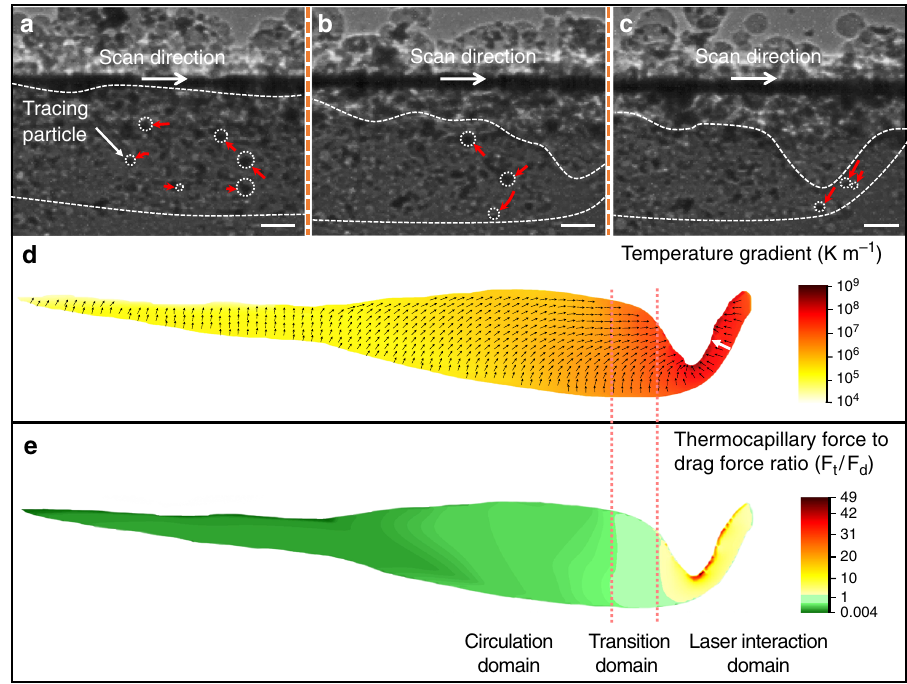
Fig. 3 Driving forces for pore motion and elimination. a – c X-ray images showing trajectories (indicated by red arrows) of the tracing particles (tungsten microparticles, marked by white dotted circles), which indicate the melt fl ow at the circulation domain ( a ) transition domain ( b ) and laser interaction domain ( c ) inside the melt pool during the LPBF process. d Temperature gradient inside the melt pool during LPBF process, obtained by multi-physics modeling with laser processing parameters the same as the in-situ experiments (see “ Methods ” section). The magnitude and direction of temperature gradient are indicated by color and black arrows, respectively. The white arrow indicates the temperature gradient increases from the solid-liquid interface (melting front) to the depression zone front wall (Fig. 5). e Ratio of thermocapillary force (F t ) to drag force (F d ) for a pore with a diameter of 10 µ m. In a – c , the laser power is 360 W, the scan speed is 1 m s − 1 and the thickness of powder layer is 100 μ m. Scale bars in a – c are 50 μ